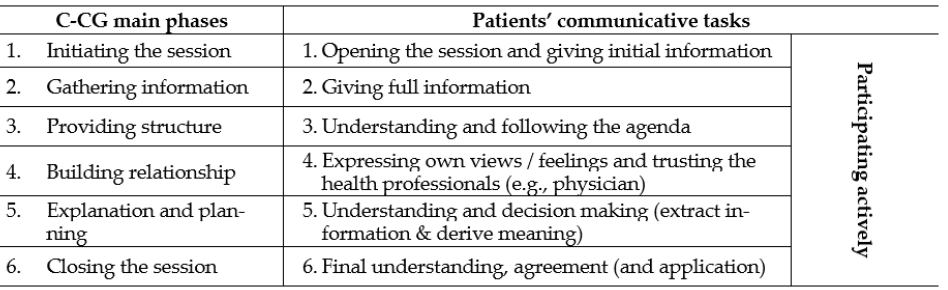
Figure 1. Overview of the main communicative practices of health professionals of the Calgary- Cambridge Guide to the Medical Interview (C ‐ CG) and main communicative tasks of patients, constituting the Conceptual Framework for Communicative Health Literacy.